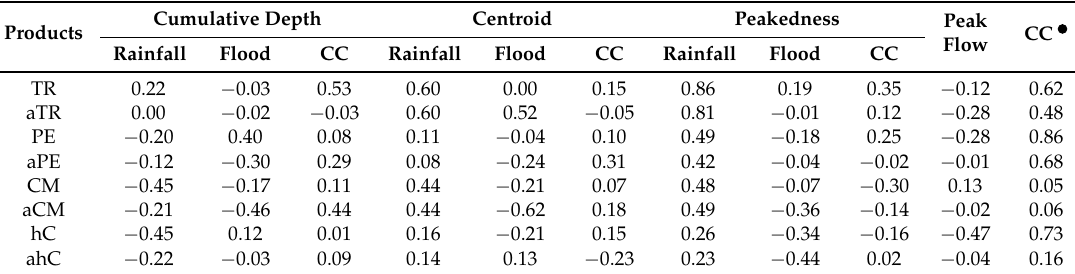
Table 3. Mean MRE for rainfall and runoff and the correlation coefficient between the biases. Products